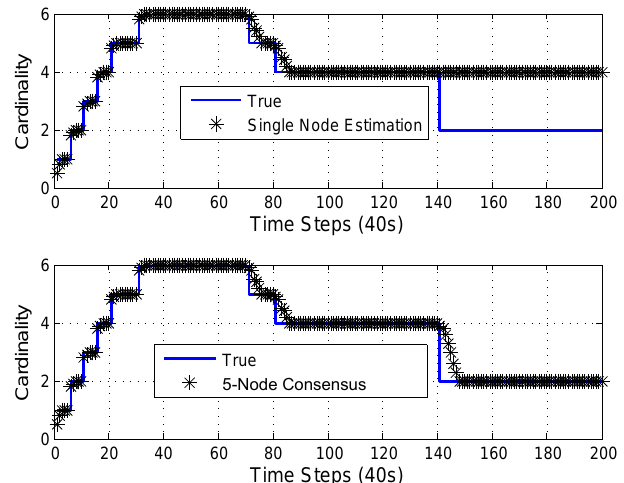
Figure 6. Cardinality performance from single-node and 5-node consensus. Two targets die at the 140th time step. A single node cannot provide cardinality estimation for objects outside the observation volume, while multiple nodes can be used to counteract the lack of observation volume of a single